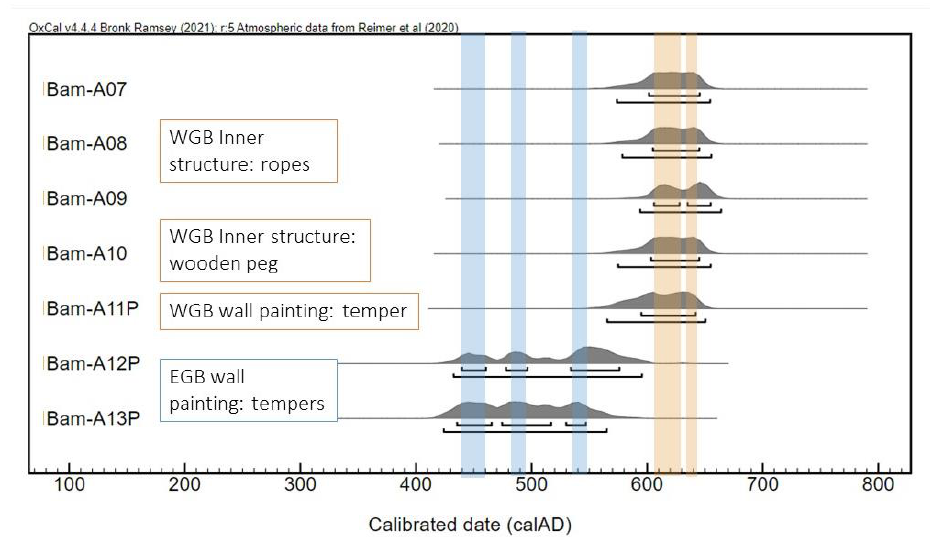
Figure 2. Radiocarbon dating results from samples taken from the EGB and WGB. Colored areas are the most probable periods of construction.